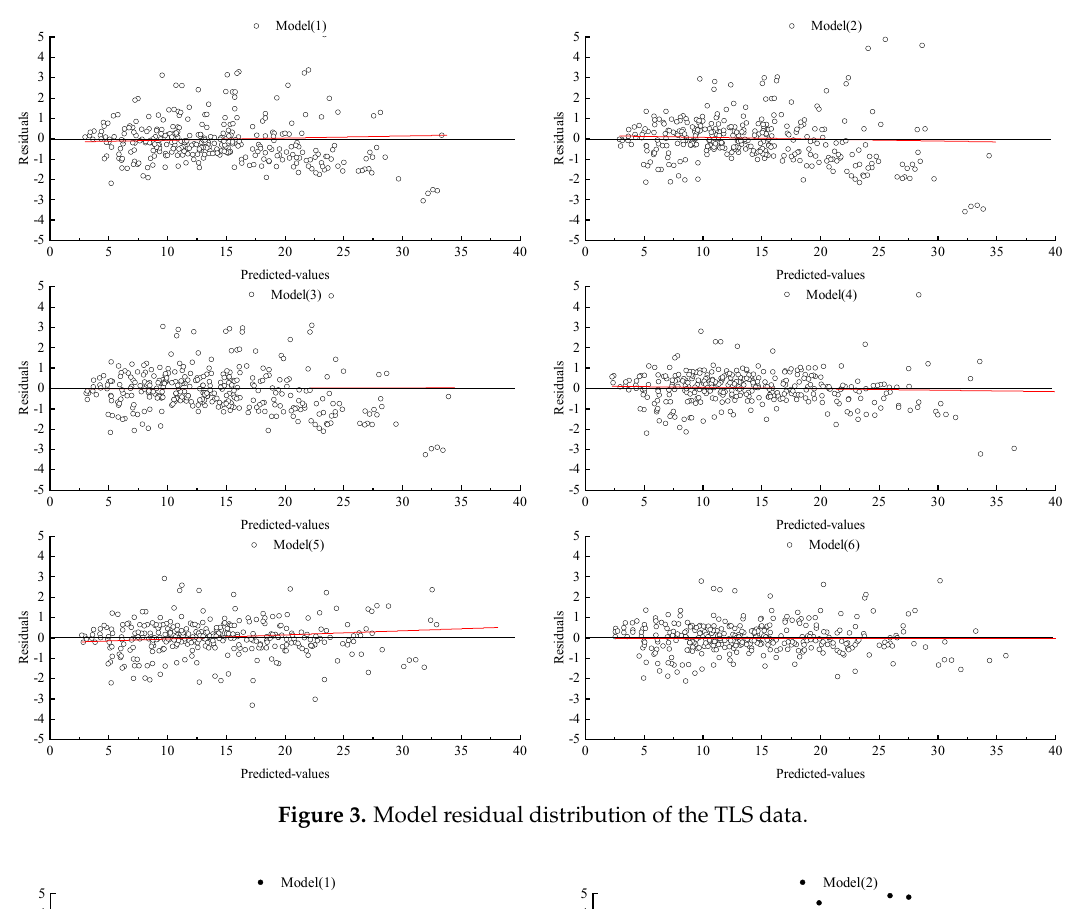
9 of 18 Table 4. Fitting statistics of the taper equation. Model